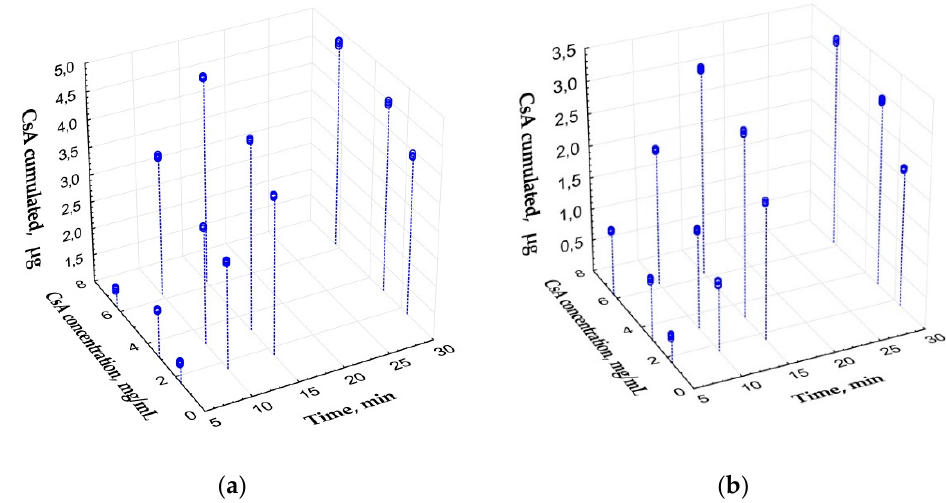
Figure 2 . Scatterplot of the amount of cumulated CsA depending on enrichment conditions ( time and CsA concentration in initial dilutions). ( a ) Porous samples. ( b ) Microfiber samples.